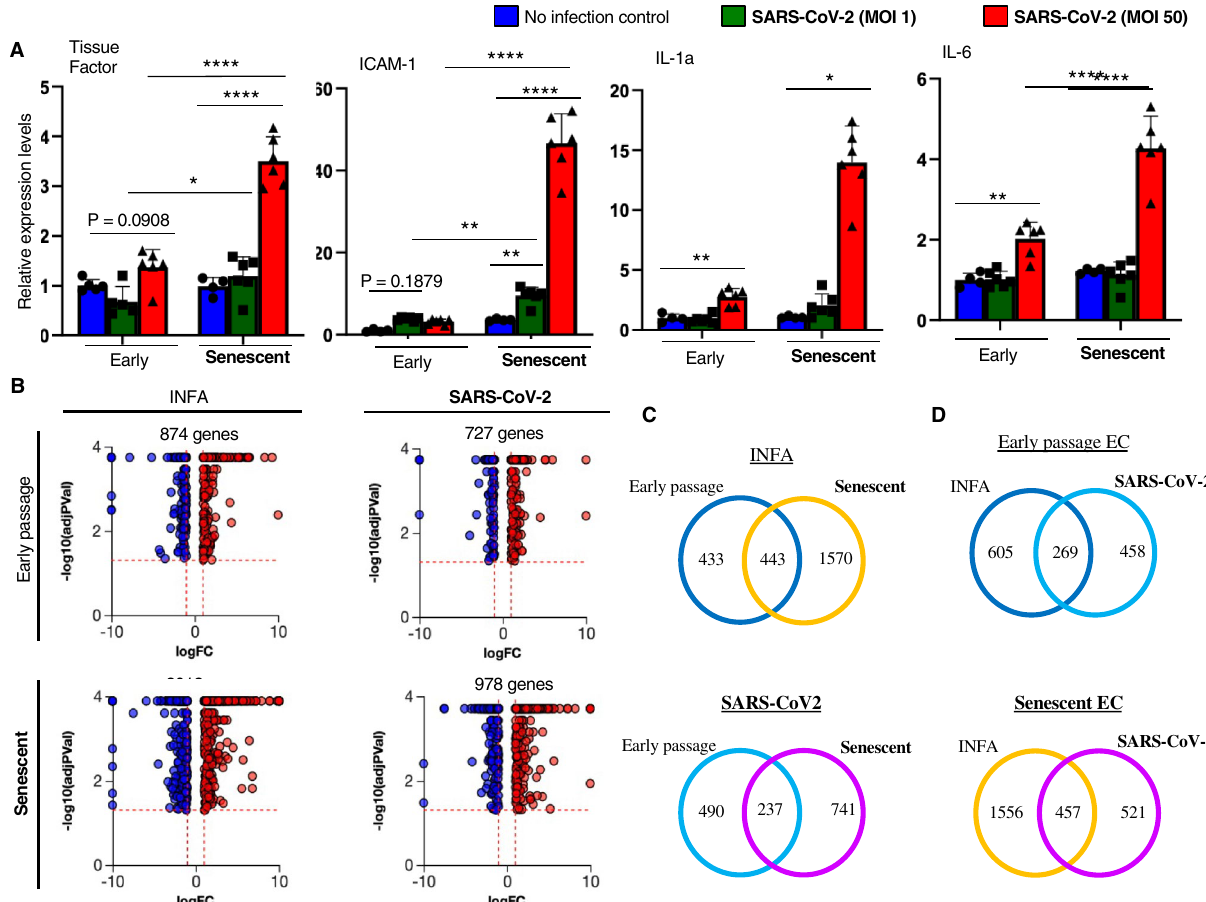
Figure 3. SARS-CoV-2 infection affects various genes expression in ECs. ( A ) Quantitative PCR analysis for tissue factor (TF), intercellular adhesion molecule-1 (ICAM-1), interleukin-1a (IL-1a), and IL-6 in early passage and senescent HUVECs with or without SARS-CoV-2 infection (1 or 50 MOI) at 72 hpi (n = 4 each for control cells; n = 6 each for infected cells). Statistical analyses were performed using one-way ANOVA with Fisher’s LSD post hoc analysis for TF, ICAM-1, and IL-6, while Kruskal-Wallis test by ranks was used for IL-1a. Data are presented as mean ± SE * P < 0.05, ** P < 0.01, and **** P < 0.0001. ( B ) Comprehensive RNA-Seq data analysis in ECs infected with SARS-CoV-2 or INFA was performed. Volcano plots for genes whose expression was significantly altered ( P < 0.05) by SARS-CoV-2 or INFA infection in early passage and senescent ECs were shown (n = 3 each). Red plots indicate the genes significantly increased more than 2-fold after the virus infection. Blue plots indicate the genes significantly ( P < 0.05) decreased less than half after the virus infection. ( C , D ) Venn Diagram analysis of the genes whose expression was significantly altered by SARS-CoV-2 or INFA infection (> 2 or < 1/2 fold) in young and senescent ECs. Numbers indicate the number of genes included in the sets of the